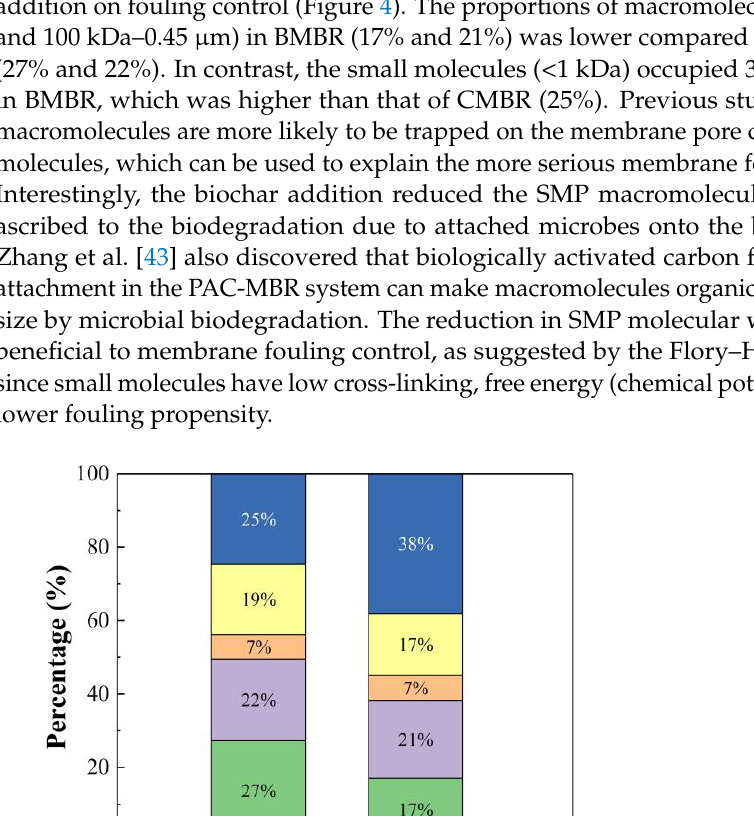
Figure 4. MW distributions of SMP in the mixed-liquor suspension from conventional MBR (CMBR) and biochar MBR (BMBR).